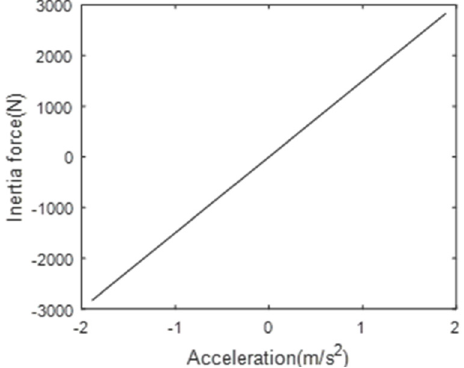
Figure 4. The curve of inertia force and acceleration.